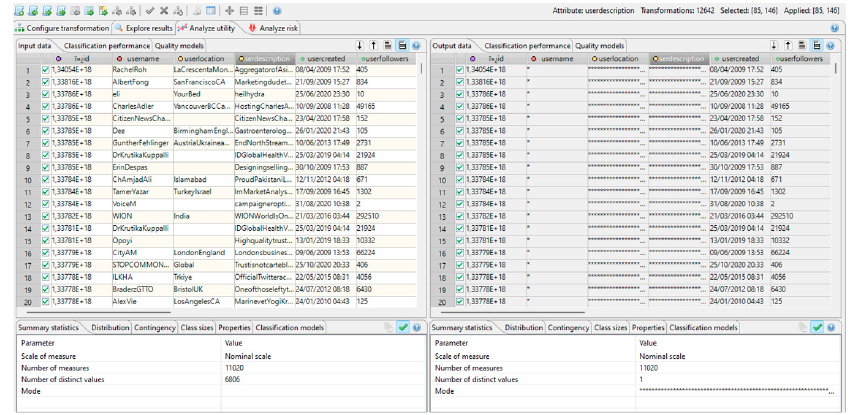
Figure 10. Anonymization Results.